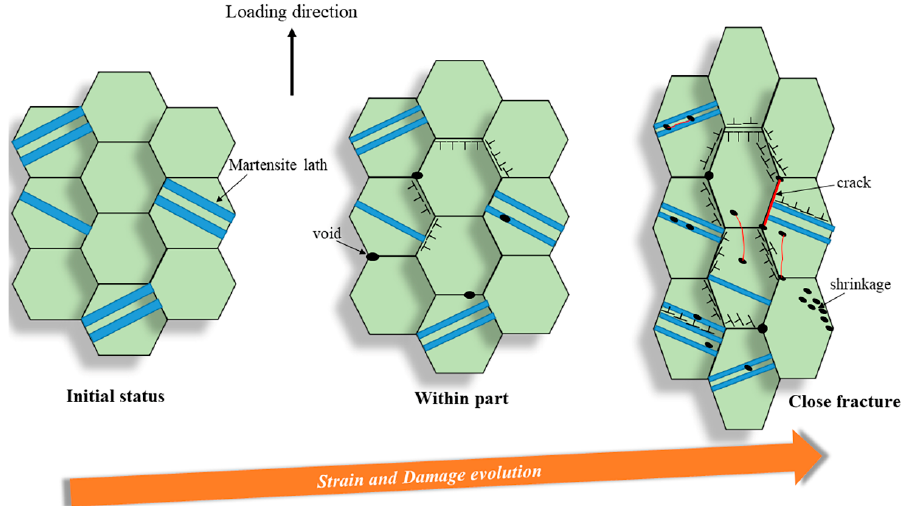
Figure 14. Schematic figure showing the failure mechanics at both strain rates under all tempera-